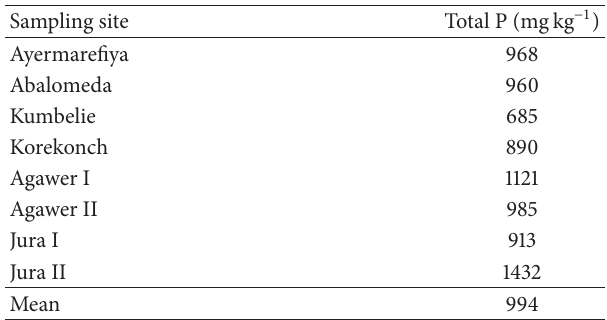
Table 5: Total phosphorus content of the